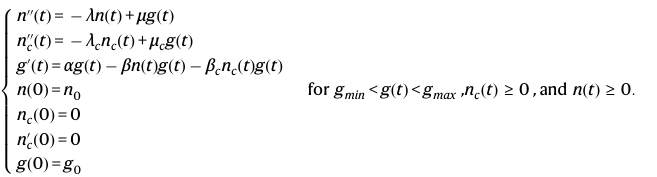
otherwise escape the control of nucleases. B Numerical simulations of Model 3 in the region of the infection space corresponding to slow phages. The CRISPR responsecreatesanewregionintheinfectionspacewhereslowphagescannowbe neutralized (shown in orange). However, some slow phages can still evade the action of CRISPR spacers and maintain the infection of the cell (yellow region). C Regions occupied by different anti-phage immune mechanisms in the infection spaceofabacterialcellaccordingtothemodelsusedinthiswork.Thedetailsofthe simulations are provided in the “ Methods ”